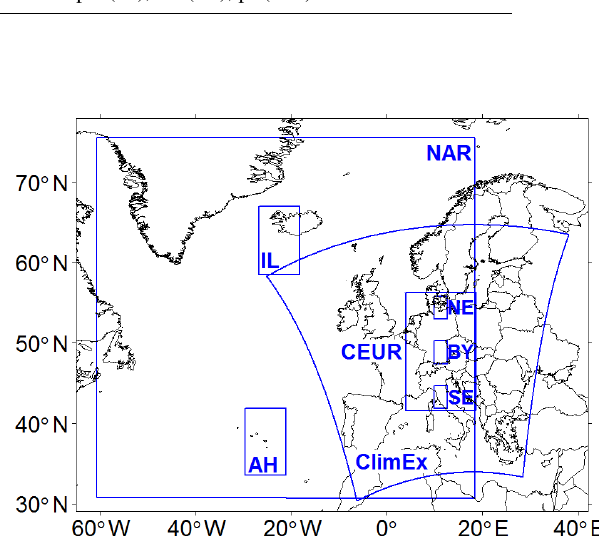
Figure 2. Regions of interest. Abbreviations and domain sizes in terms of GCM grid cells (2.8 ◦ ) are as follows: AH – Azores High (3 × 3); IL – Icelandic Low (3 × 3); NAR – large-scale North Atlantic region (28 × 16); CEUR – central Europe (5 × 5); NE – northern Europe (1); BY – Bavaria (1); SE – southern Europe (1); ClimEx – domain used in ClimEx project (extent approximately 22 × 12 after resampling to GCM